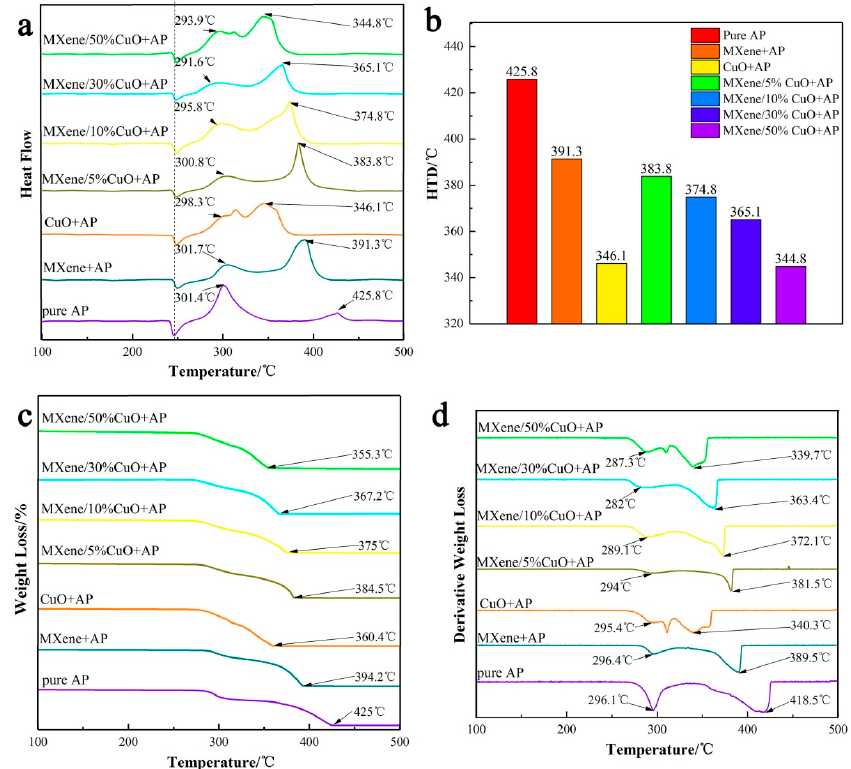
Figure 5. Differential scanning calorimetry (DSC) curves of ammonium perchlorate (AP) in the absence and presence of 2 wt% catalysts ( a ), histogram of the corresponding high-temperature decomposition (HTD) of AP from DSC results ( b ), thermal gravimetric analysis (TGA) and differential TGA (DTGA) curves of AP in the absence and presence of 2 wt% catalysts ( c , d ).